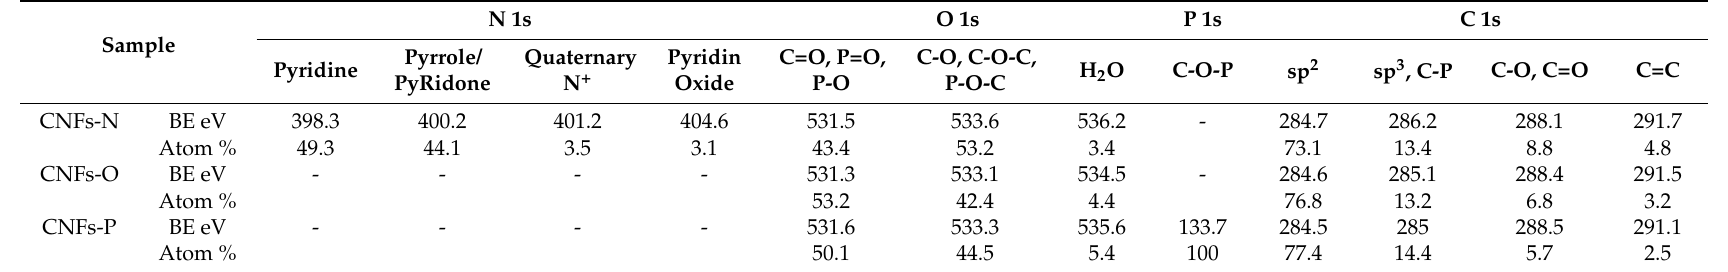
Table 2. XPS analysis of the different supports